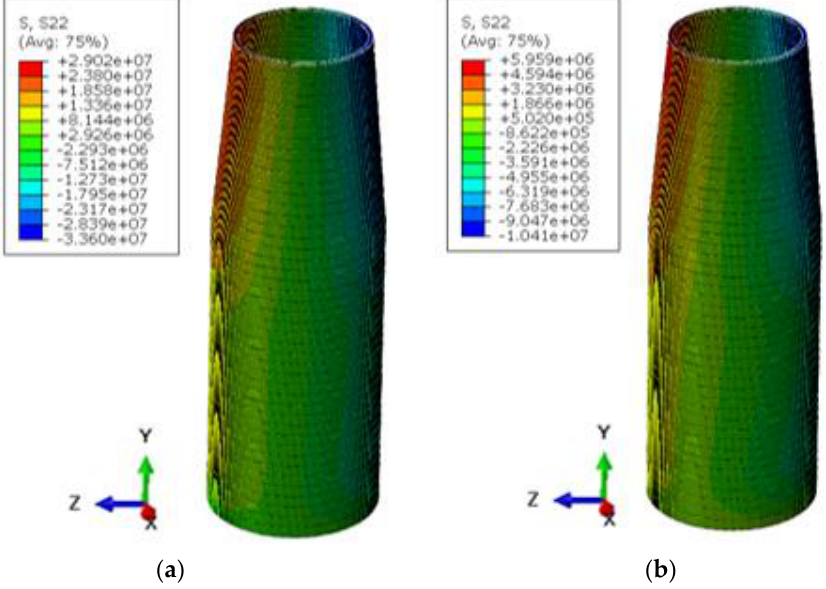
Figure 21. Von Mises stresses: ( a ) Extreme sea state, ( b ) Normal conditions. The influence of the number of bolts on the different parameters was also investigated (see Figure 22).